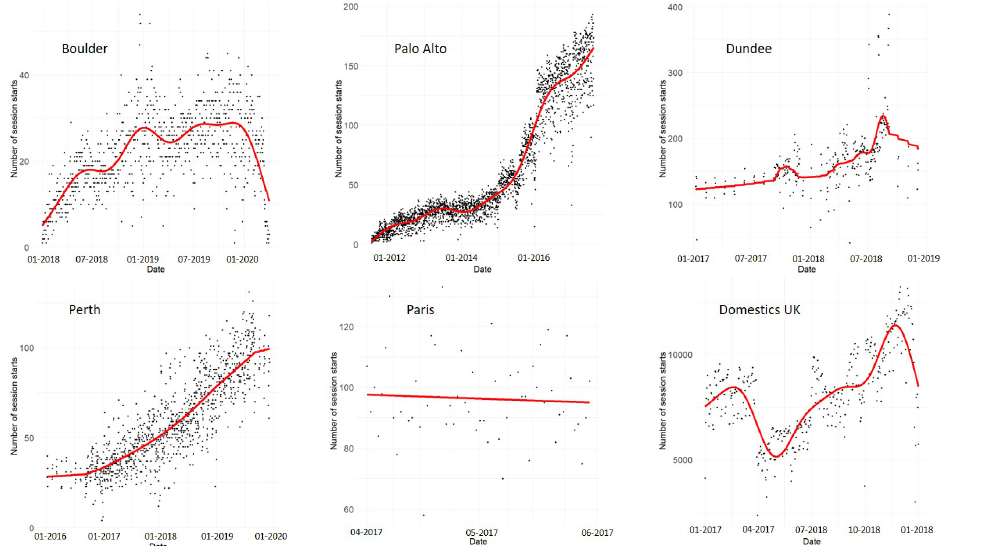
Figure 4. The black dots represent the daily number of sessions while the red curve is the output of a generalized additive model used to estimate the trend ( mgcv package in Ref.